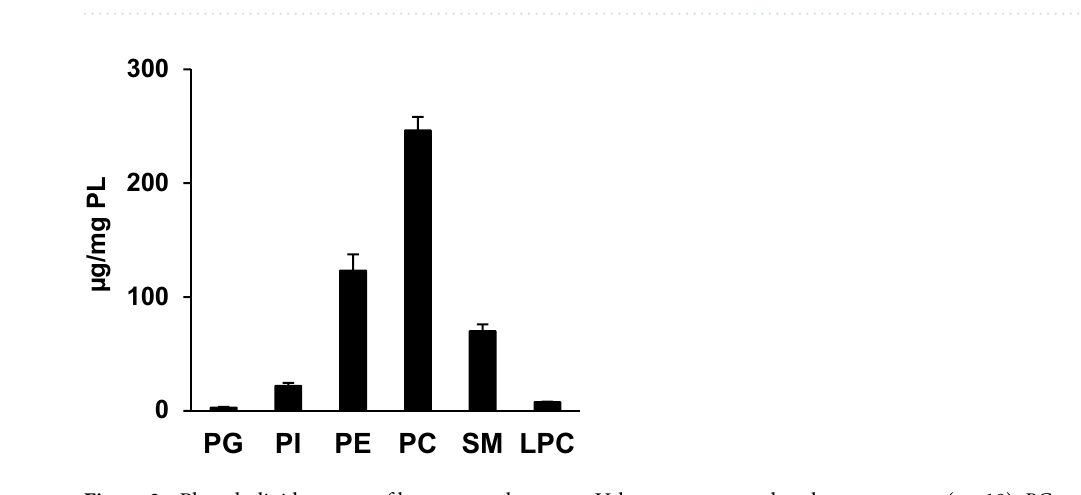
Figure 2. Phospholipid content of human nasal mucosa. Values are presented as the mean ± sem (n = 19). PG phosphatidylglycerol, PI phosphatidylinositol, PE phosphatidylethanolamine, PC phosphatidylcholine, SM sphingomyelin, LPC